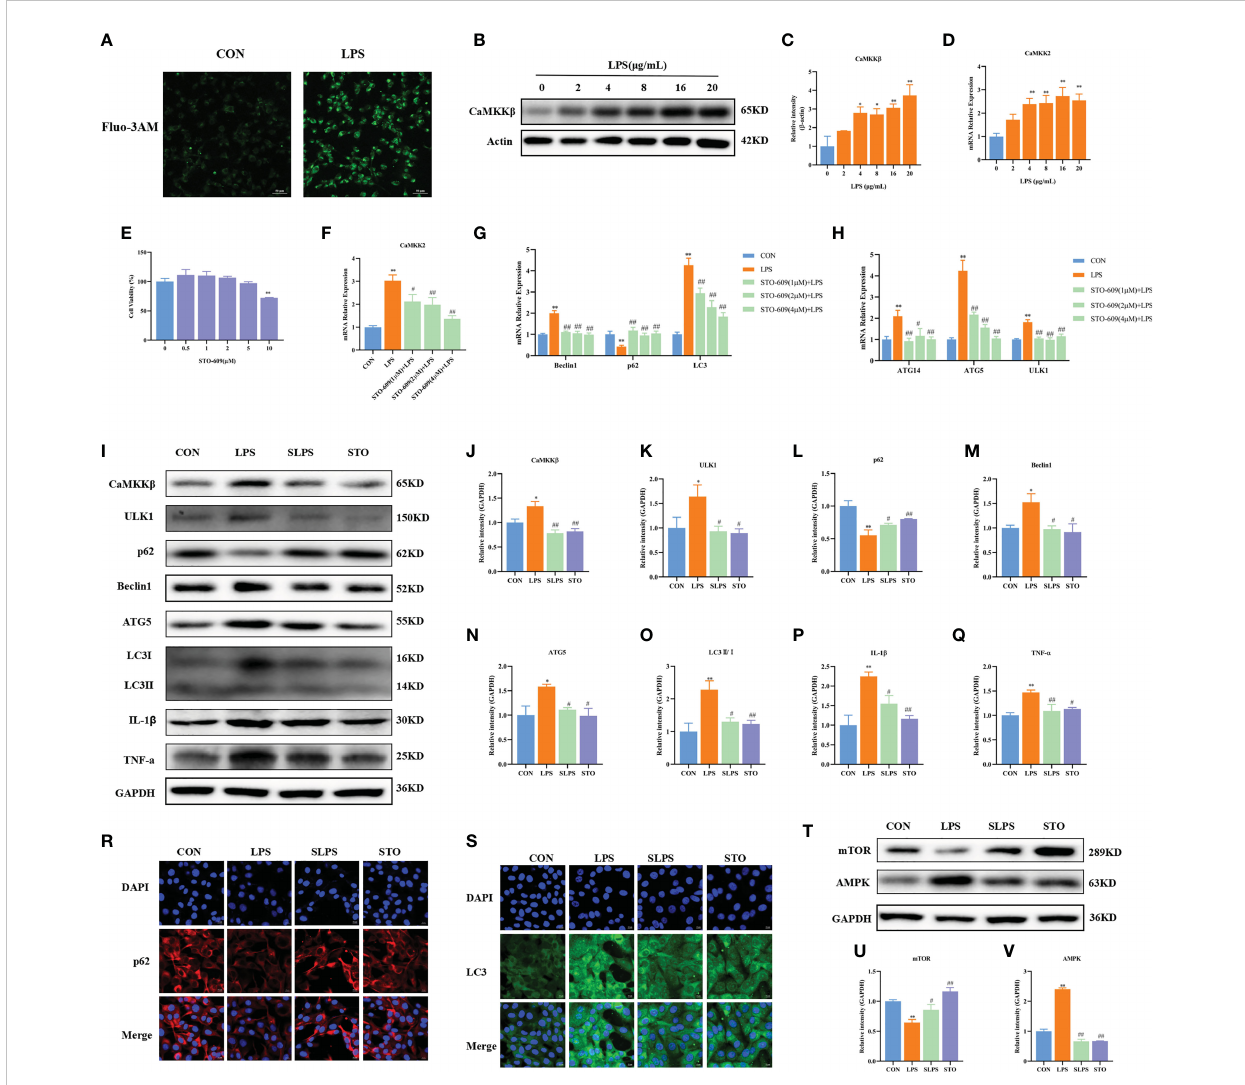
FIGURE 6 Effect of STO-609 pretreatment on LPS-induced autophagy and in fl ammation in BMECs. Fluorescence intensity of intracellular Ca 2+ . Scale bar, 50 m m (A) . Effects of different concentrations of LPS on the mRNA and protein expression of CaMKK b in BMECs for 3 h (B – D) . Effects of STO-609 on the cell viability of BMECs (E) . Effects of STO-609 pretreatment with different concentrations on LPS-induced autophagy-related genes and the mRNA expression of CaMKK2 in BMECs (F – H) . WB representative bands and quantitative result of autophagy and in fl ammation proteins in BMECs treated with LPS after STO-609 pretreatment (I – Q) . Immuno fl uorescence results of p62 and LC3 in BMECs treated with LPS after STO-609 pretreatment. Scale bar, 10 m m (R, S) . Effect of STO pretreatment on AMPK and mTOR protein expression in BMECs (T – V) . * p < 0.05, ** p < 0.01, representing signi fi cant difference compared with the Ctrl group; # p < 0.05 and ## p < 0.01, representing signi fi cant difference compared with